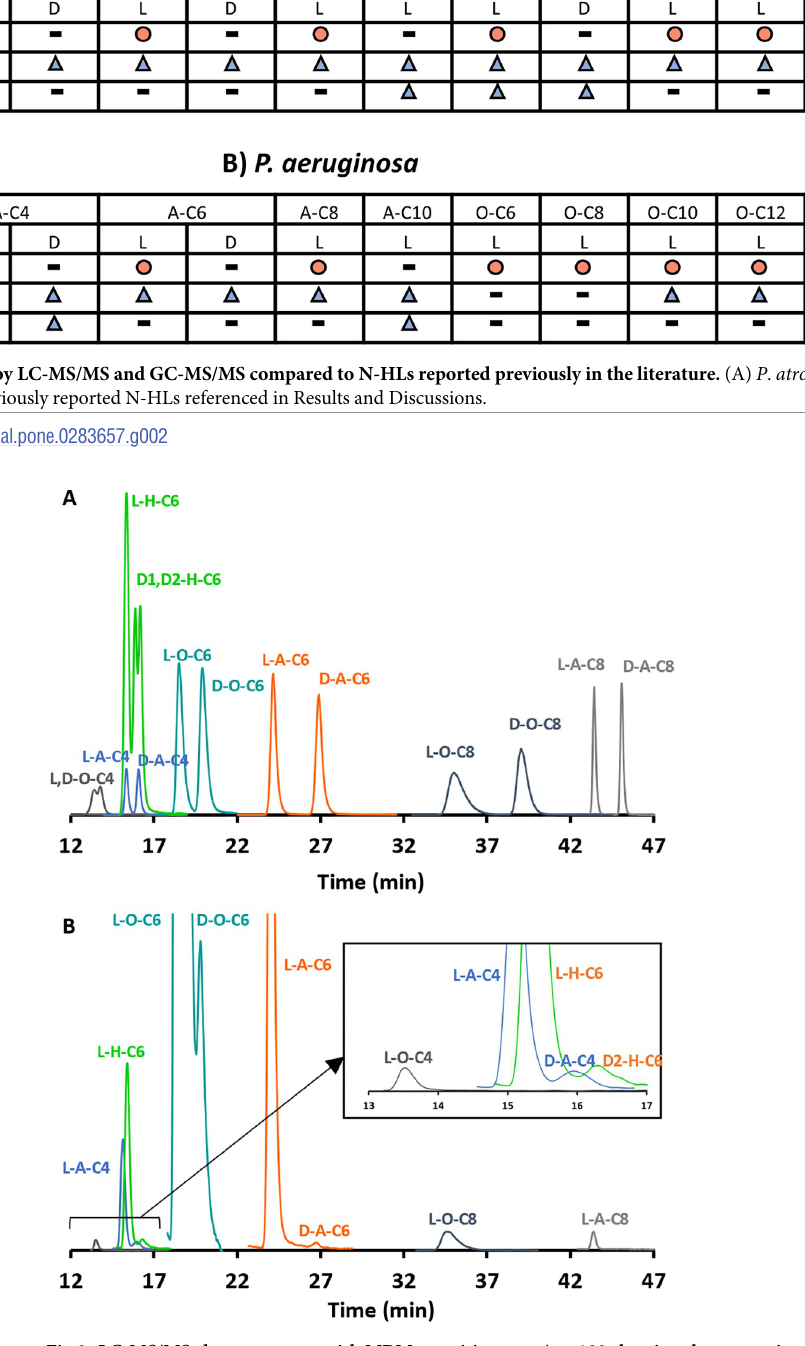
Fig 3. LC-MS/MS chromatogram with MRM transition to m/z = 102 showing the separation of most prominent N-HLs. (A) standard solution and (B) 123 h growth culture of P . atrosepticum . See Materials and methods section for details. Baselines normalized for